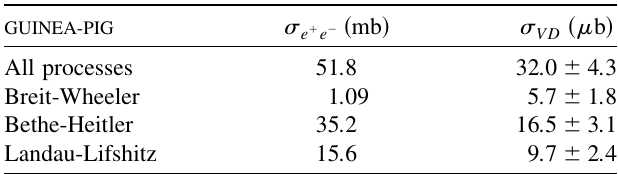
TABLE V. Cross sections for incoherent pair production, (cid:5) , and for the pair background reaching the VD, (cid:5) e (cid:2) e (cid:1) predicted by GUINEA-PIG , with the ‘‘beam-size effect’’ activated (cid:7) m for the maximum virtuality in the equiva- and using Q e max lent photon spectrum instead of the default